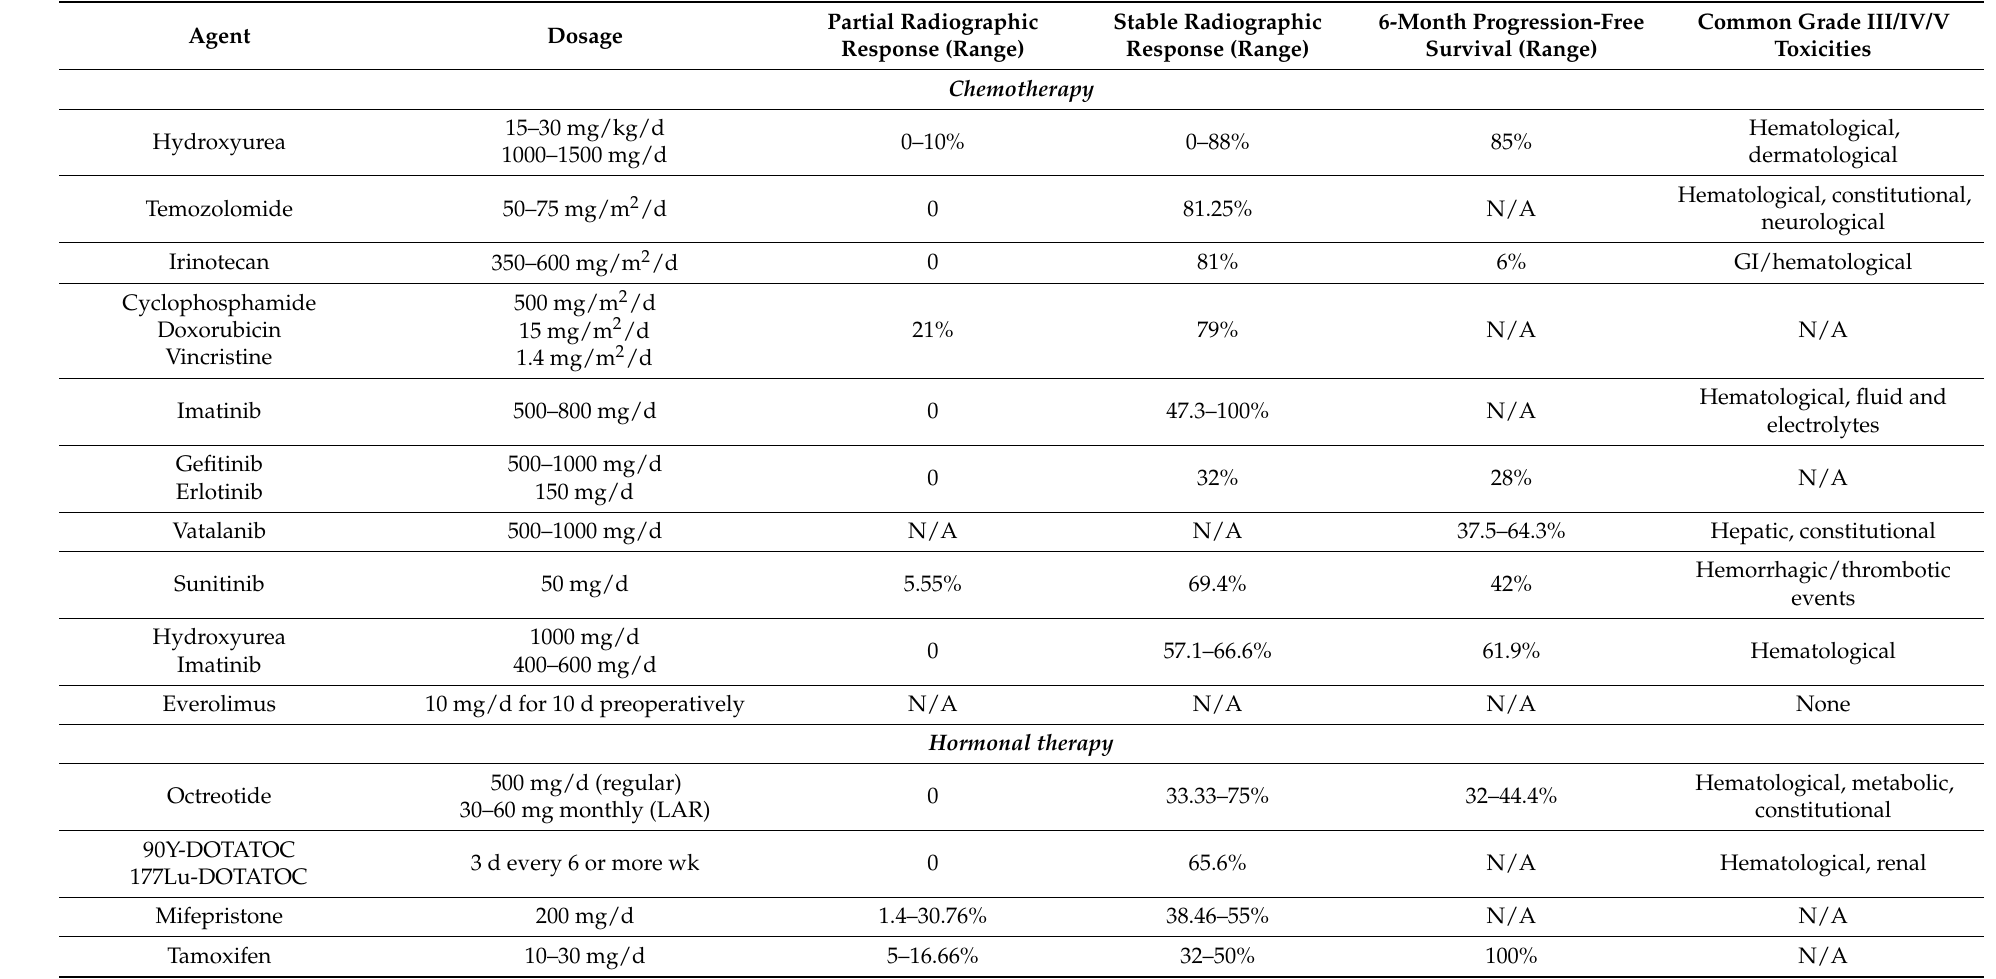
Table 4. Characteristics of studied pharmacotherapeutic